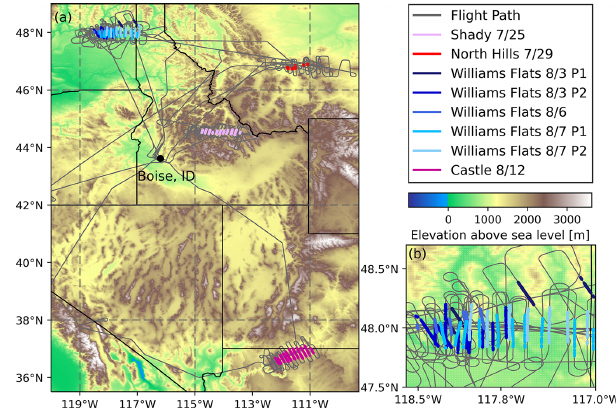
Figure 1. (a) Map of in-plume sections for the eight sets of transects used in this study from the FIREX-AQ campaign between 25 July and 12 August 2019. (b) Map of the in-plume sections of the five sets of transects of the Williams Flats